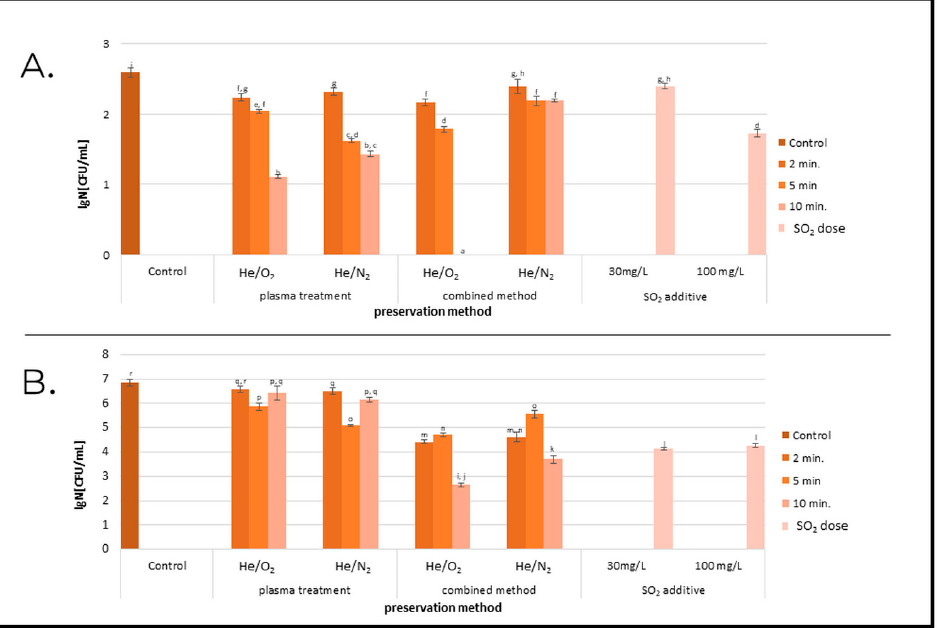
Figure 1. Effect of inactivation of bacterial growth at different preservation methods. ( A )—before storage. ( B )—after storage. Cold plasma exposure time—2, 5, or 10 min. Working gas was a mixture of He/O 2 or He/N 2 ; a–r Values with the different superscript letters are significantly different ( p < 0.05).